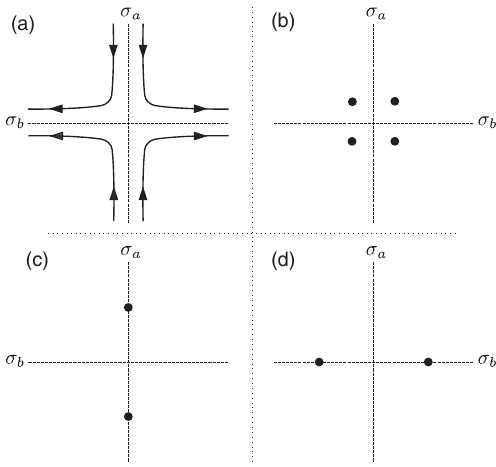
FIG. 10. (a) E 8 root state for C 2 v symmetry. Solid lines represent an E 8 state on each half-plane, with edge chiralities indicated by the arrows. (b) Microscopic construction of the E 8 root state in terms of sheets of ν ¼ 4 IQH states (dashed lines), with edge chiralities as indicated by the arrows.